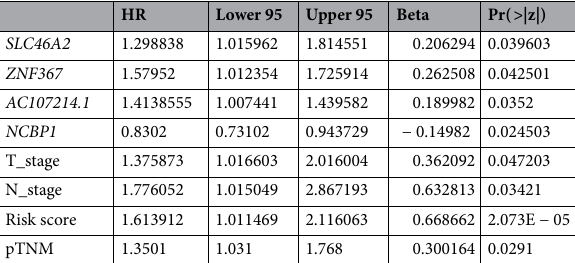
Table 9. Multivariate Cox Regression